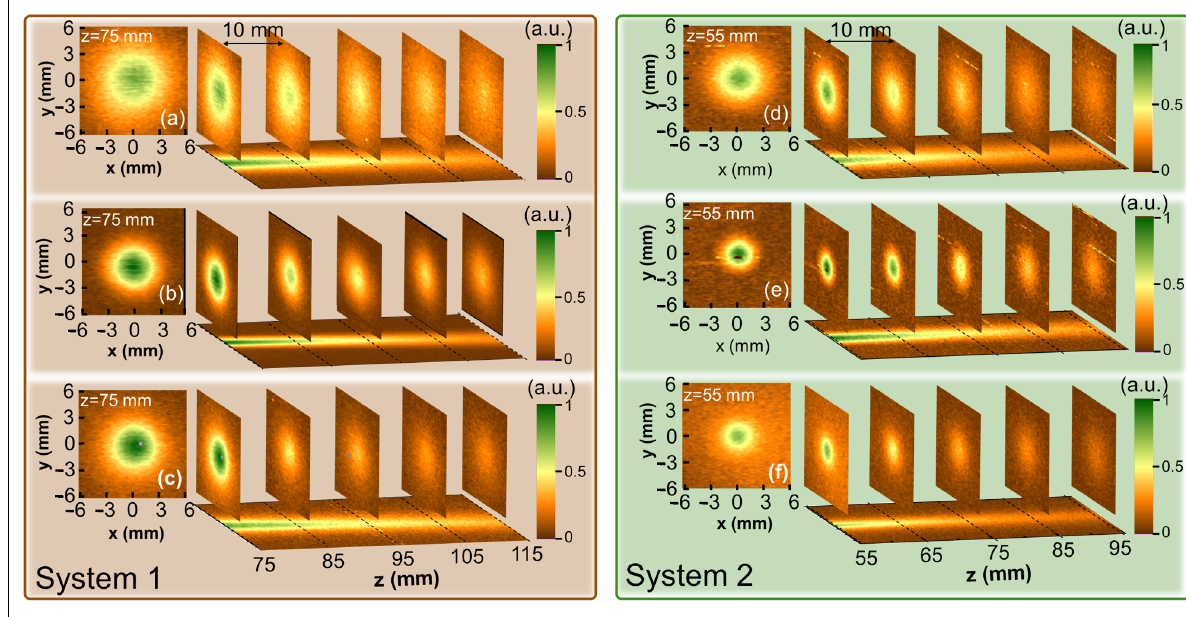
Figure 4. Radiation pattern distributions and beam evolution along the propagation axis recorded by antenna-coupled Ti- µ bolometers for two different THz-TDS systems. The signal is normalized to maximum values of the relevant plots. Left panels displays spatial mode profile at starting positions. Note different mode spatial diameter if compare both systems at the same distance from the lens tip. It stems from different thicknesses (350 µ m vs. 500 µ m) of emitters used in experimental setups. As emitter thickness of System 1 was not well matched to the lens focal distance, it results to a larger divergence of the emitted mode profile. Beam pattern profile evolution was investigated in the range of 75 mm–115 mm and 55 mm–95 mm after the collimating lens in System 1 and System 2, respectively. Distances were selected according to mechanical limitations of geometrical dimensions of the used emitters and detectors. Five transverse mode profiles samples were recorded every 10 mm along z -direction for each TDS system. Panels ( a – c )—System 1; panels ( d – f )—System 2. Panels ( a , d )—0.3 THz; panels ( b , e )—0.7 THz; panels ( c , f )—wideband Ti- µ bolometer. Please note that the spatial profiles and beam propagation properties of both systems exhibit no essential